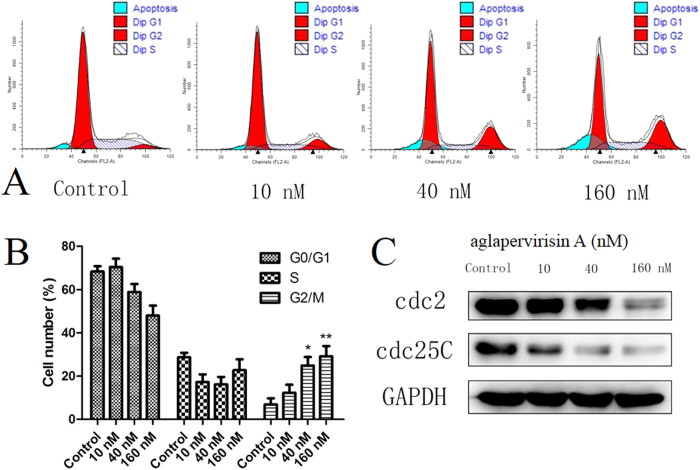
Compound 1 induces cell cycle arrest and apoptotic cell death in HepG2 cells.(A) Compound 1 induces cell cycle arrest at the G2/M boundary. The cells were treated with vehicle or with 1 at 0 μM, 6.25 μM, 12.5 μM, or 25 μM for 48 h, and the cell cycle distribution was assessed by flow cytometry; (B) Percentages of cells in different phases of the cell cycle; (C) The levels of Cdc2 and Cdc25C were measured by western blotting using GAPDH as the loading control. Data are presented as the means ± SD of three experiments. *P < 0.05, **P < 0.01 compared to the control group.